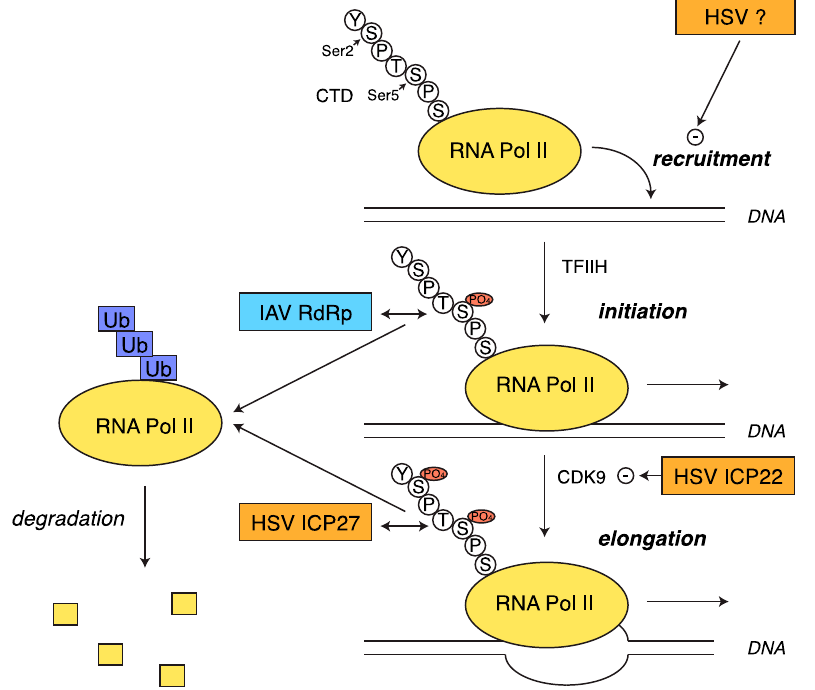
Figure 4. Both HSV-1 and IAV block host transcription. Transcription by RNA polymerase II (Pol II) consists of multiple steps: recruitment to the DNA, initiation, mediated by phosphorylation of the serine 5 (Ser5) of the C -terminal domain (CTD) of the large subunit of the Pol II complex by TFIIH,